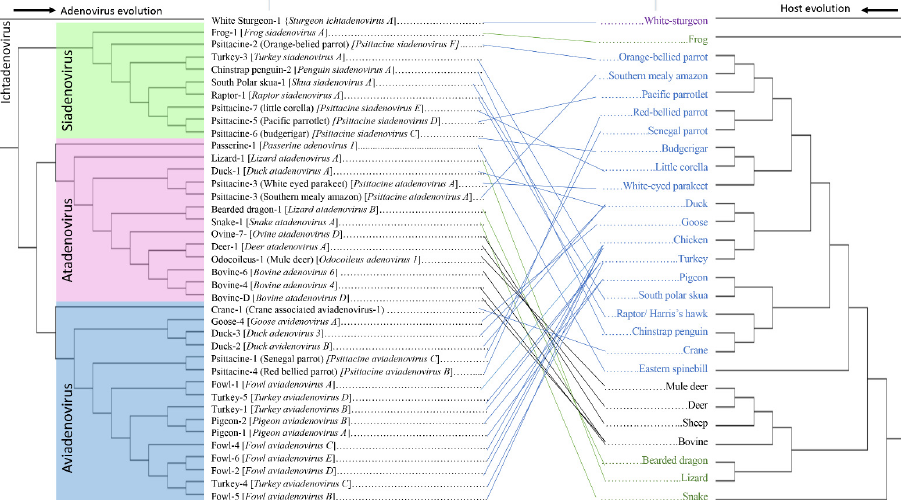
Figure 2. An illustration showing the evolution of three major adenovirus genera with their respective host species denoting the adenovirus cross-species transmission to completely different hosts more than coevolution with host species. Phylogenetic trees of adenoviruses using DNA polymerase sequences and respective hosts using cytochrome c oxidase subunit 1 were generated and used to develop tanglegram in Dendroscope (version 3.8.2, Free Software Foundation, Boston, Massachusetts, United States). Bootstrap support for individual virus and host trees are shown in Supplementary Figures S2 and S3. The labels at branch tips refer to the original adenovirus species name, and lines indicate the association with the host organism. The genus Ichtadenovirus is left as an outgroup, and the genus Mastadenovirus and Testadenovirus is not presented. Three major adenovirus genera are considered, and bird (blue), mammal (black), and reptiles/amphibians (green) hosts are shown in different colours.